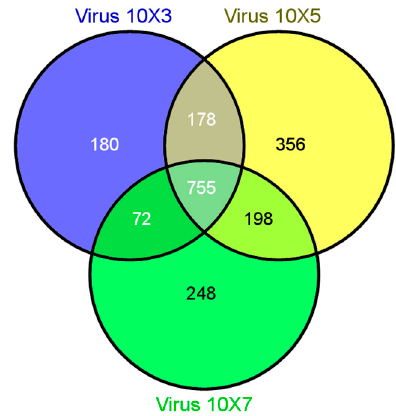
Figure 3. Venn diagram showing different affected genes, which are either common or unique among different treatment doses of WNV (10 3 , 10 5 and 10 7 PFU) in mouse cerebellar slice cultures (CSCs).